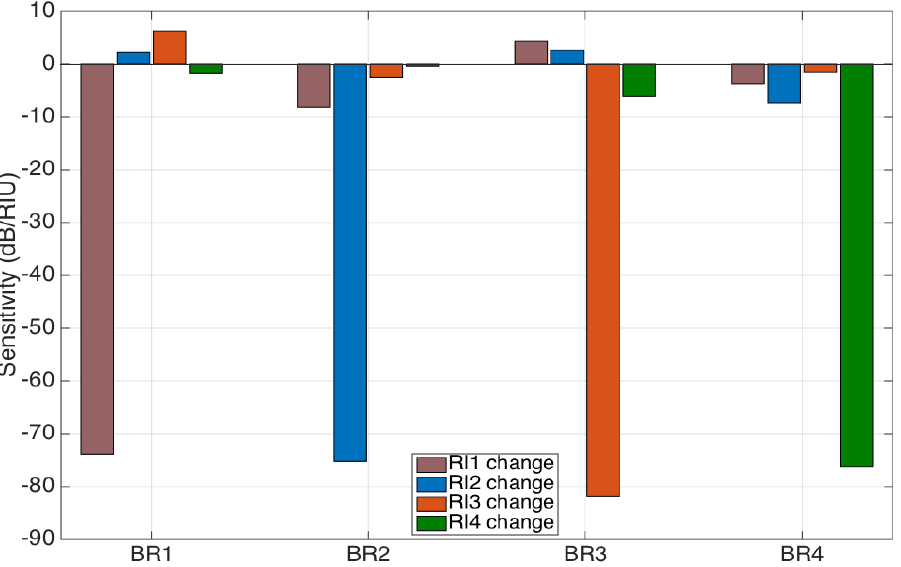
Figure 7. Sensitivity recorded for each BR sensor (left to right: BR1, BR2, BR3, and BR4) experienced when the RI changes for one sensor (saddle: BR1 changes; blue: BR2 changes; orange: BR3 changes; green BR4 changes). All sensitivity values are estimated as the slope of the linear fits observed in Figure 6.